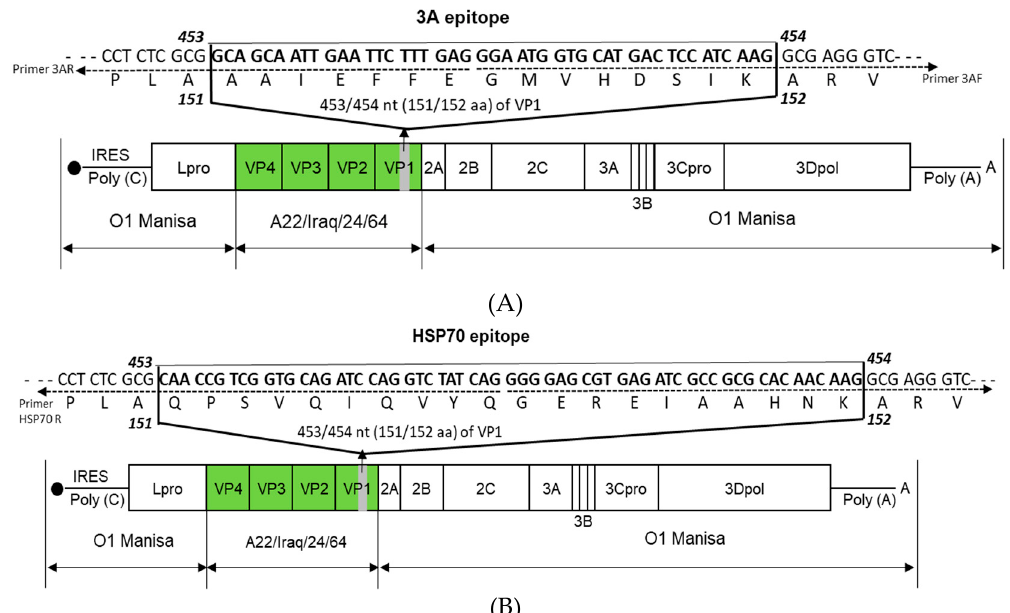
Figure 1. Construction of the immunopotent foot-and-mouth disease virus (FMDV) vaccine strains A-3A and A-HSP70. ( A , B ) represent: ( A ) A-3A; ( B ) A-HSP70. FMDV T cell epitope 3A (the 15 amino acid residues in VP1) ( A ) and enhanced long-term immunity protein HSP70 (the 20 amino acid residues of VP1) ( B ) were selected as target molecules for preparation of immunopotent virus. The A22 (A22-R) P1, where the P1 region of O1 Manisa is substituted with A22 P1, was used as the backbone for